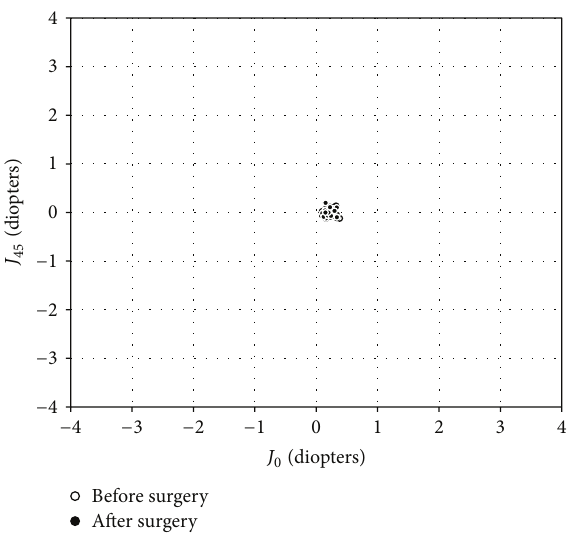
Figure 2: Power vector analysis of posterior corneal astigmatism before and after refractive lenticule extraction (ReLEx), plotted as an astigmatic vector for each eye, referenced to the spectacle